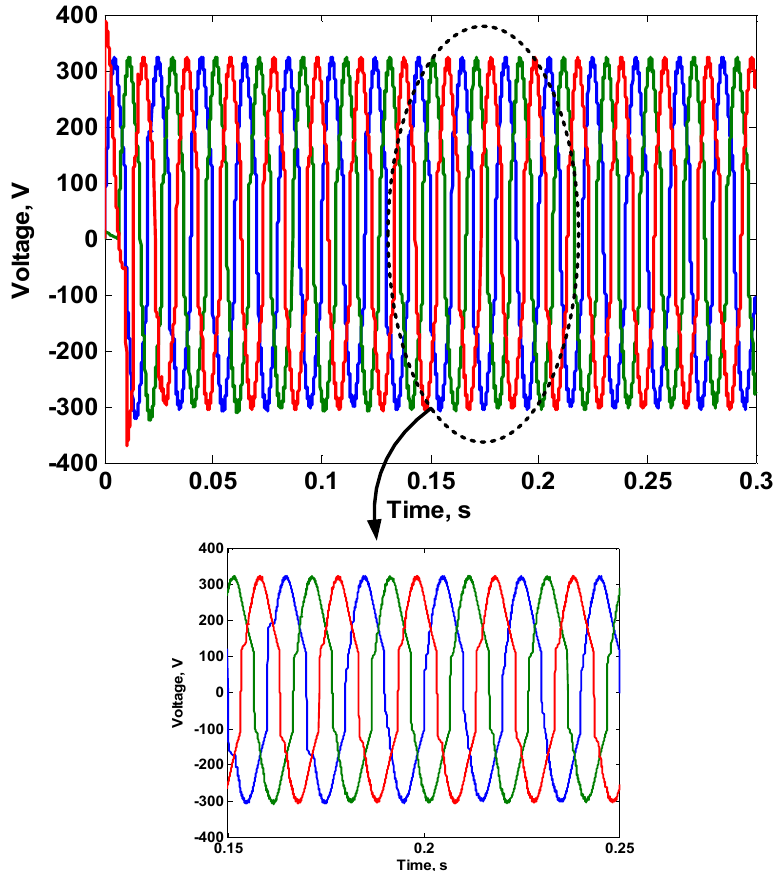
Figure 19. Conditions of 220 V, 50 Hz 3-Phase Applied Voltage at the Motor Terminals.